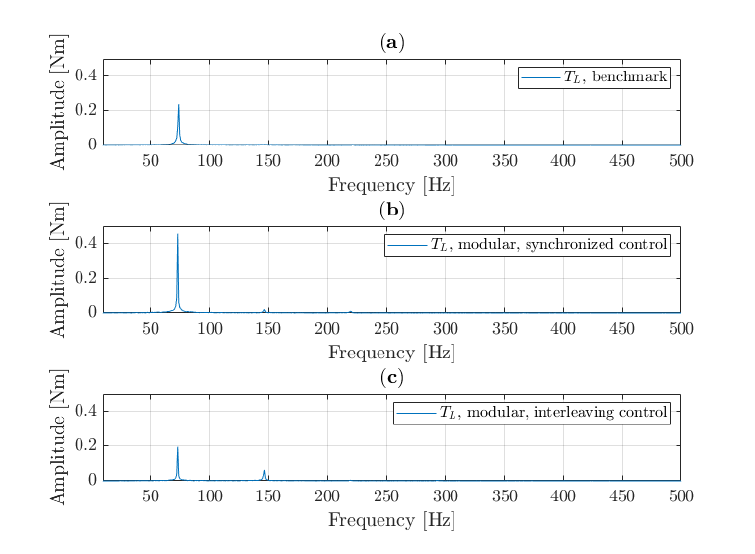
Figure 7. Simulated torque ripple amplitude monitored at the load in ( a ) the benchmark scenario, 0.24 Nm at the resonance mode; ( b ) the modular scenario, 0.46 Nm; ( c ) the modular scenario with interleaving control, 0.20